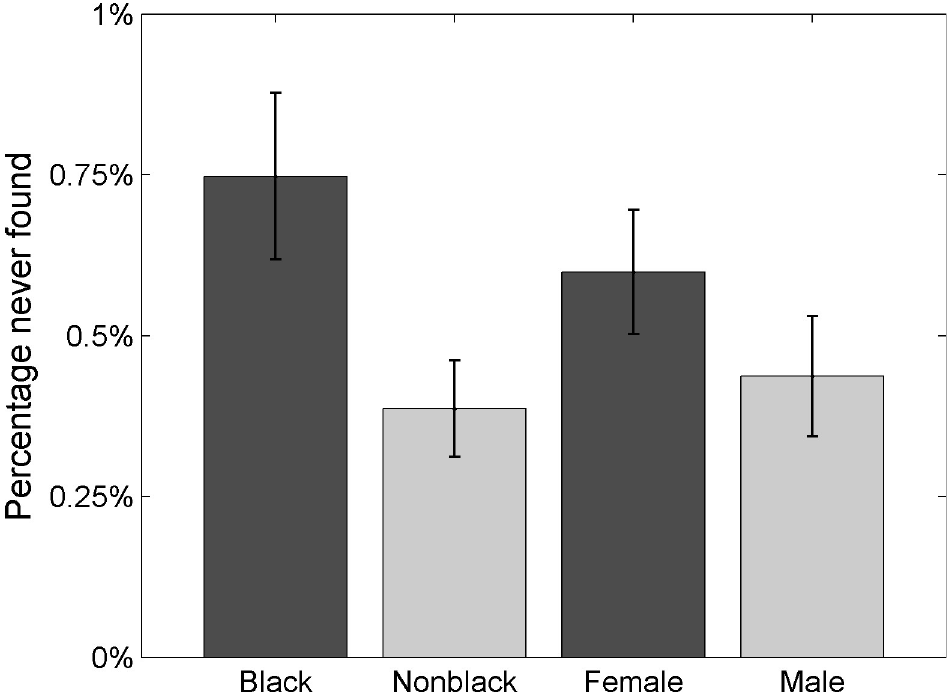
Fig 1. Percentage of children never found, by race and